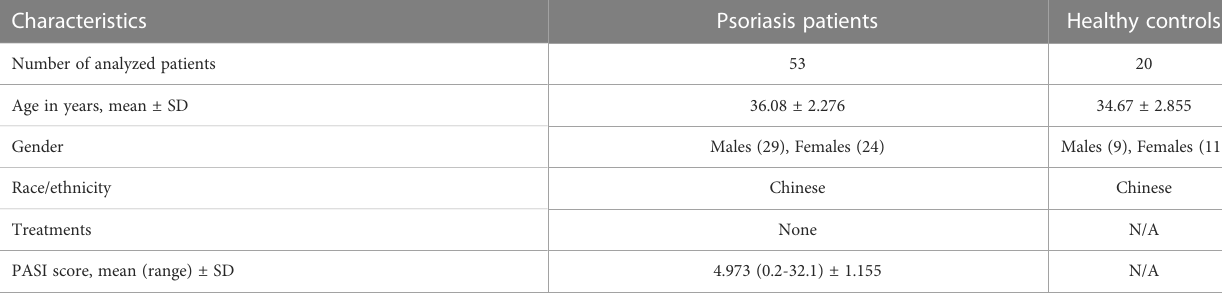
TABLE 1 Characteristics of Psoriasis patients and Healthy controls for detection of IL-35 in plasma.